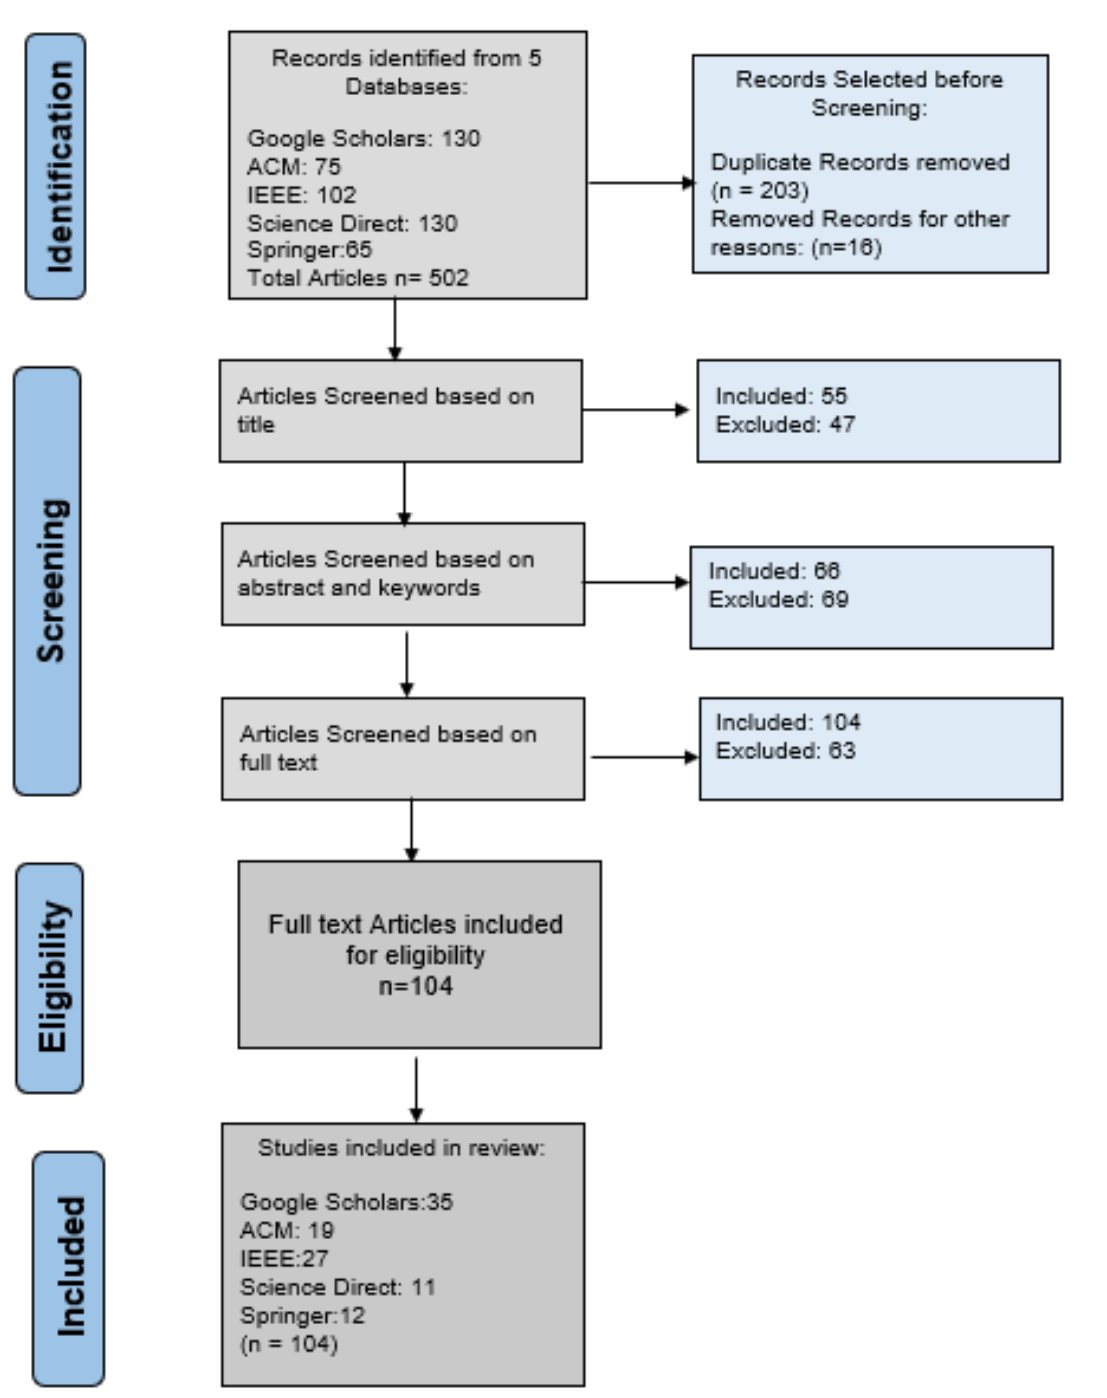
Figure 3. Flow diagram showing the screening process for the systematic